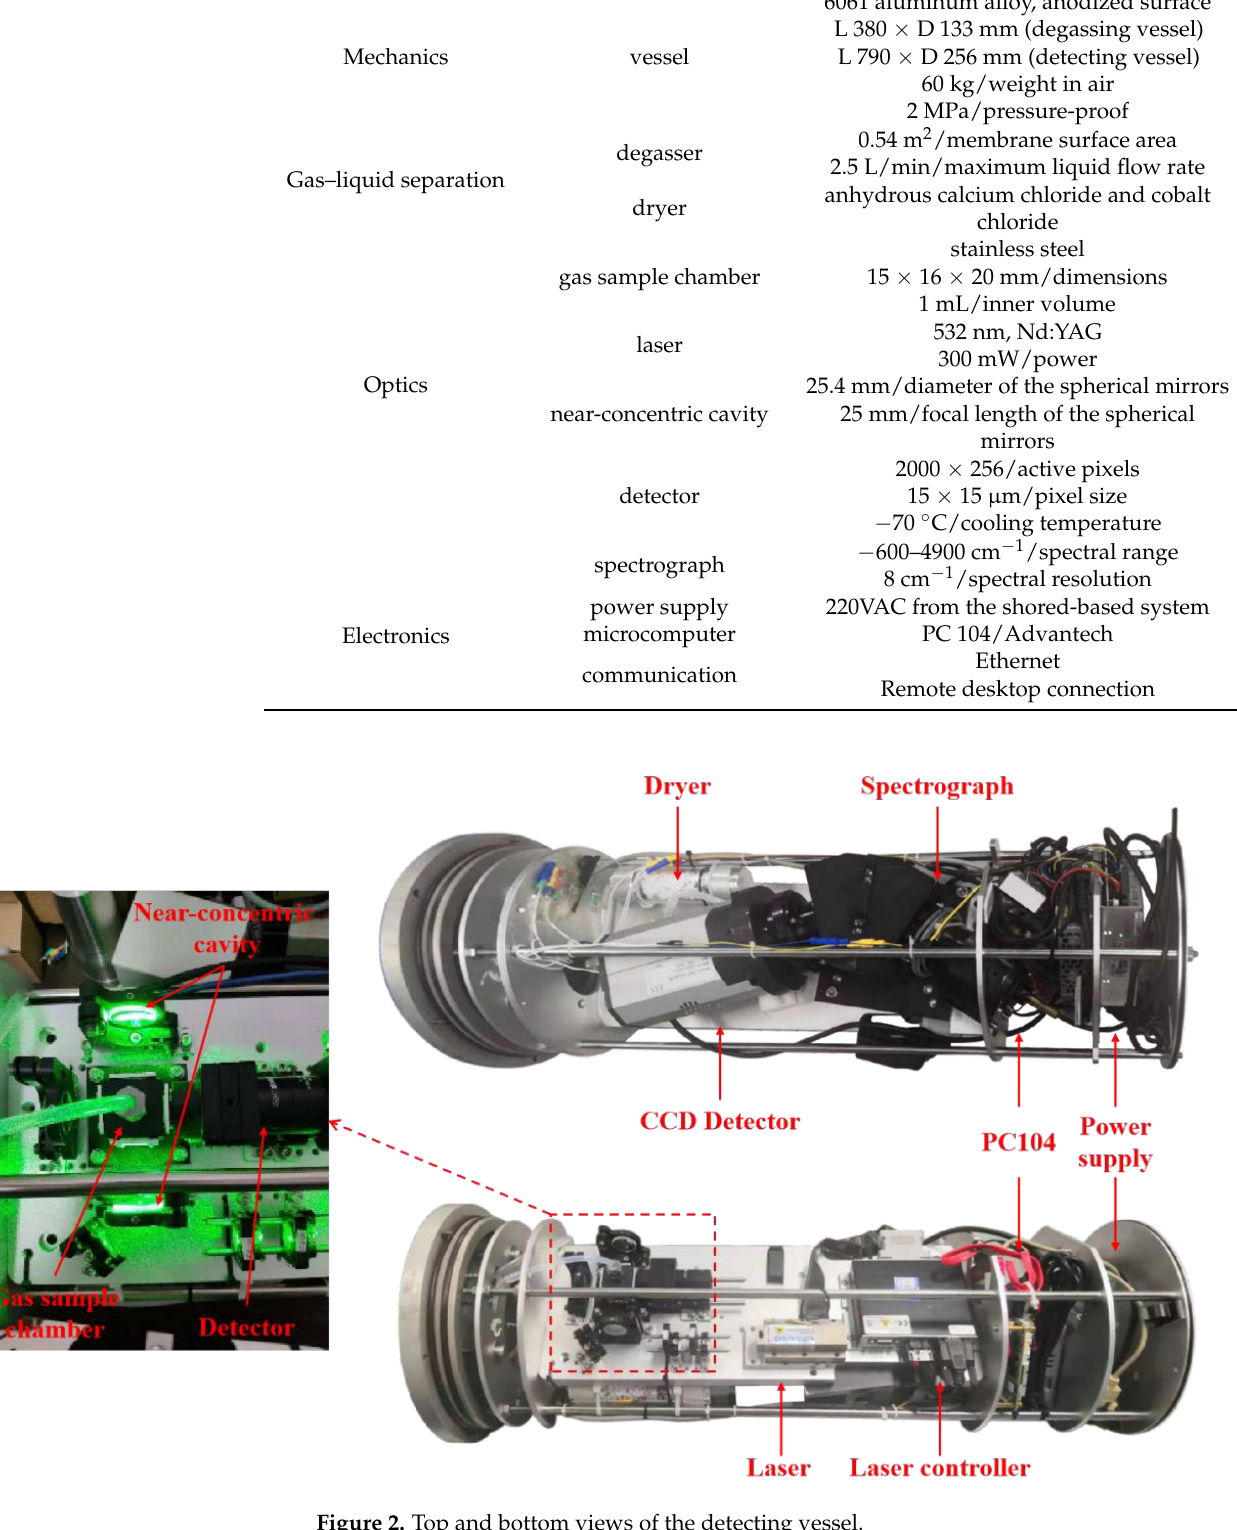
Figure 2. Top and bottom views of the detecting vessel.